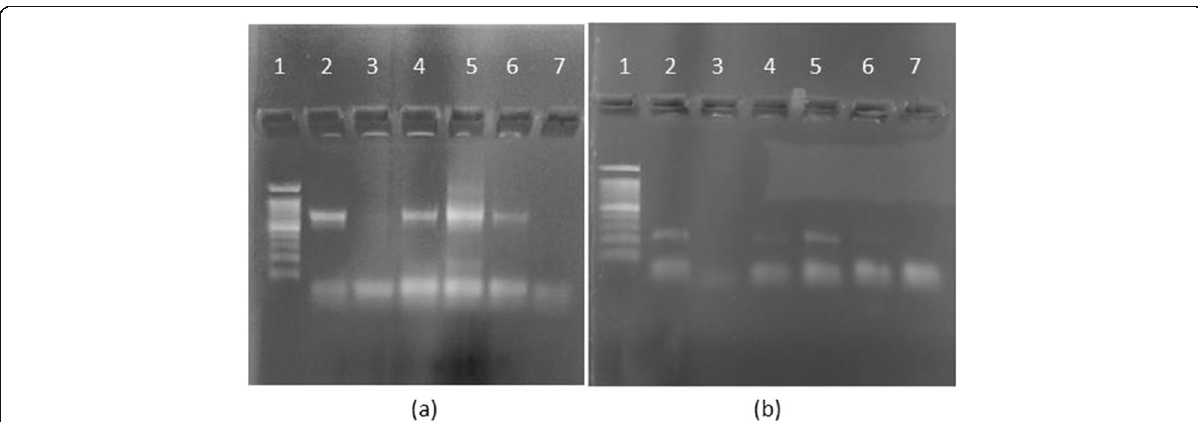
Fig. 7 Detection of microbial contaminants in milk sample by PCR. a 16s r-DNA: lane 1 — 100 bp ladder, lane 2 — 16s colony PCR (positive control), lane 3 — Amul milk, lane 4 — Gokul milk, lane 5 — local cow milk, lane 6 — local buffalo milk, lane 7 — negative control. b β -galactocidase: lane 1 — 100 bp ladder, lane 2 — β -galactocidase colony PCR (positive control), lane 3 — Amul milk, lane 4 — Gokul milk, lane 5 — local cow milk, lane 6 — local buffalo milk, lane 7 — negative